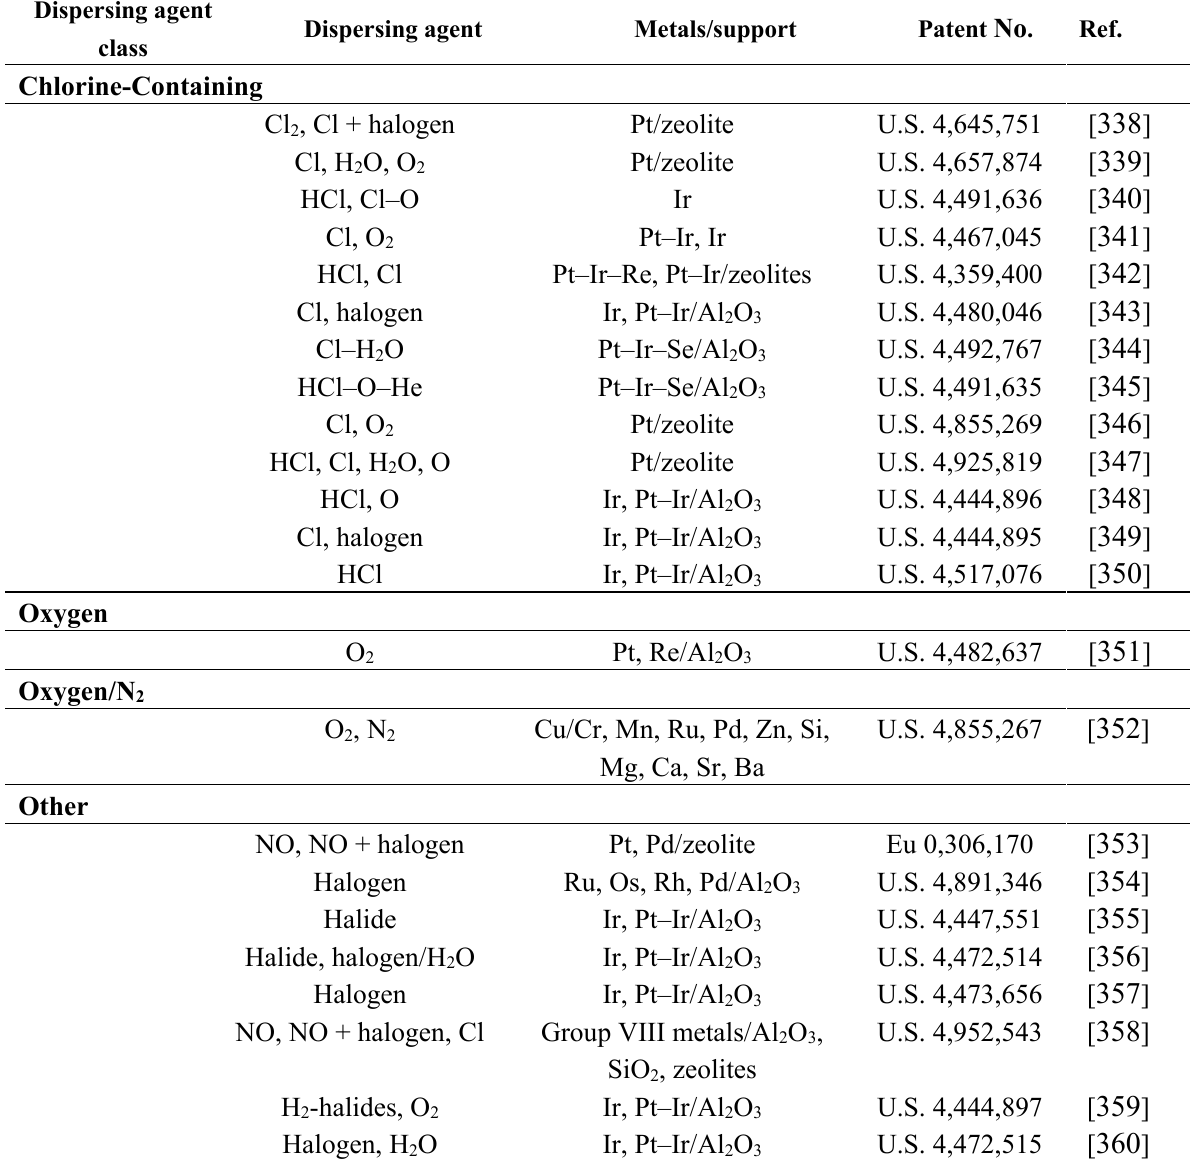
Table 23. Representative Patents Prior to 1990 Treating Catalyst